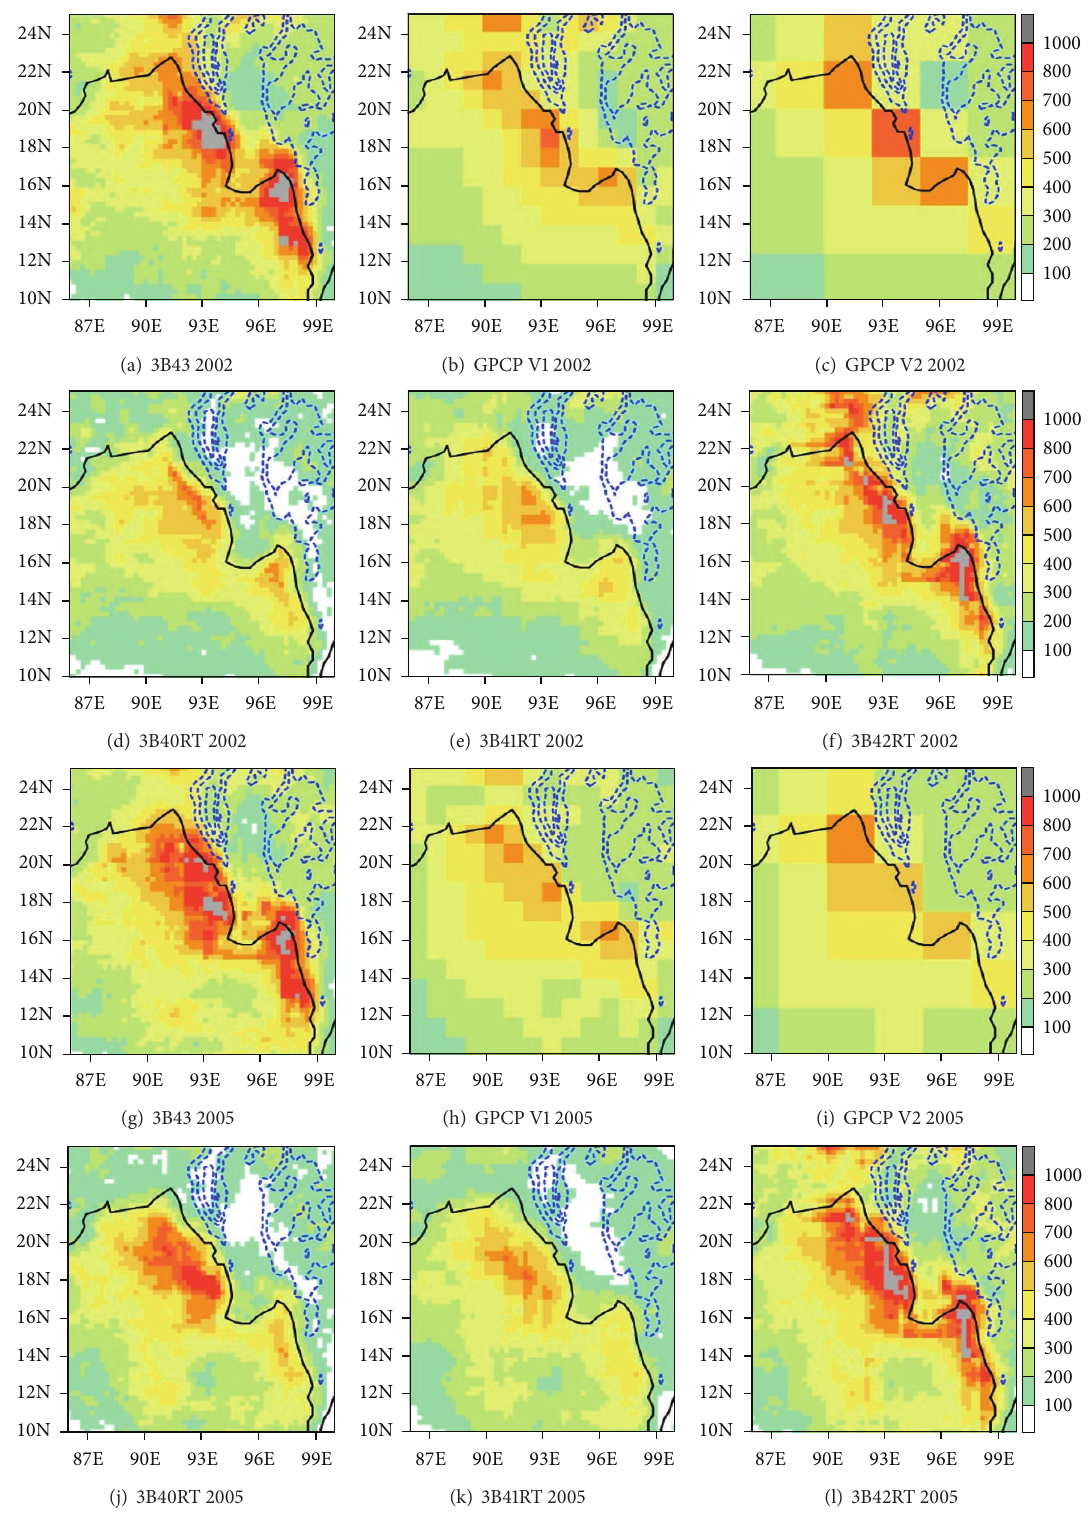
Figure 3: JJA mean precipitation (mmmonth −1 ) distribution in 2002 ((a)–(f)) and 2005 ((g)–(l)). The blue dotted contours mark the topography at 500 m, 1000m, and 1500 m above sea